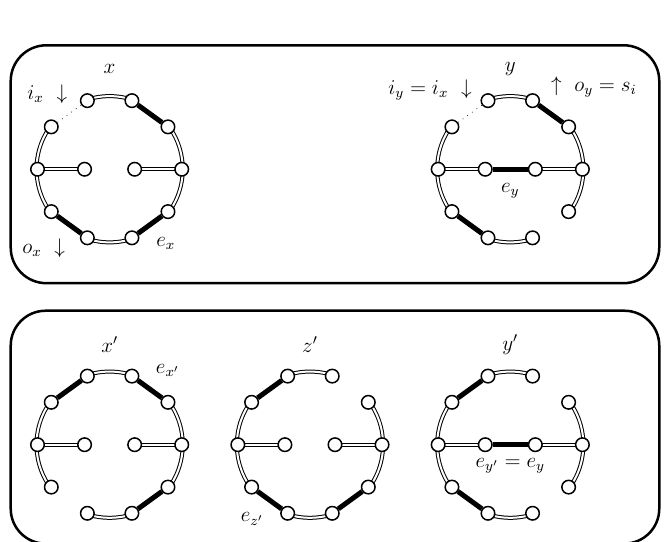
Figure 15: Case 4. c .iii, when B ∗ is true. Figure 15. Case 4. c .iii, when B ∗ is